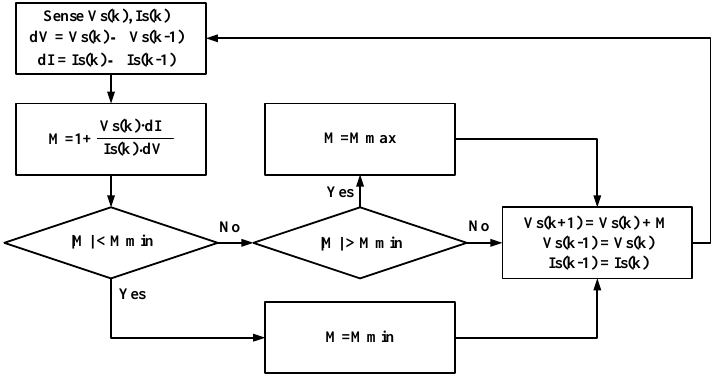
Figure 13. Algorithm flow chart of an incremental conductance method with variable amplitude.